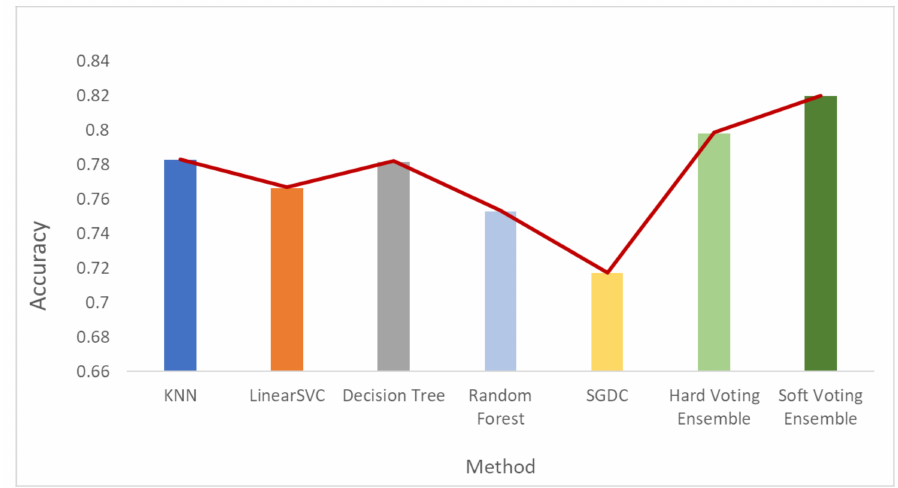
Figure 6. Accuracy results when the initial dataset was used.